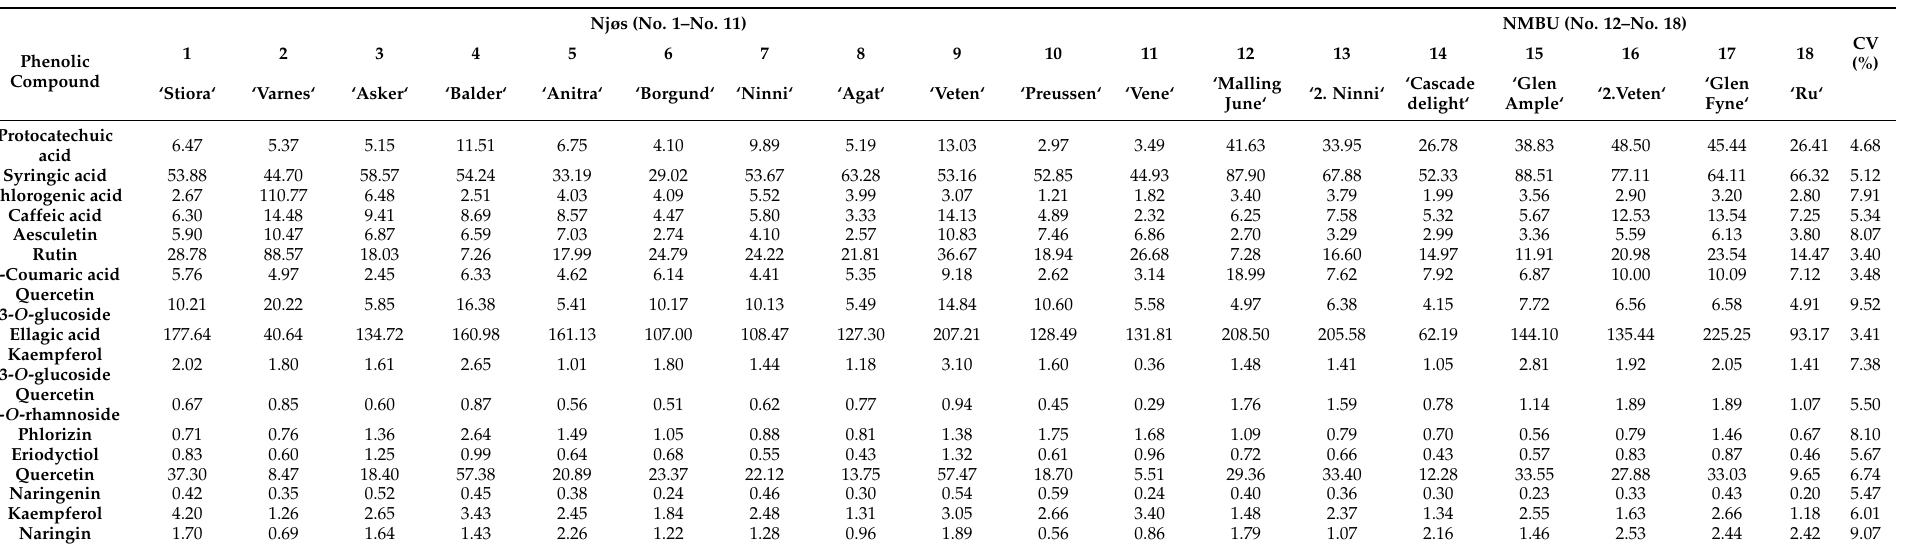
Table 5. The averages of the values of contents of polyphenols (mg/kg) in 18 raspberry extract samples during the two-year collection from two Norwegian regions (Njøs No. 1–No. 11 and NMBU No. 12–No. 18) ( p ≤